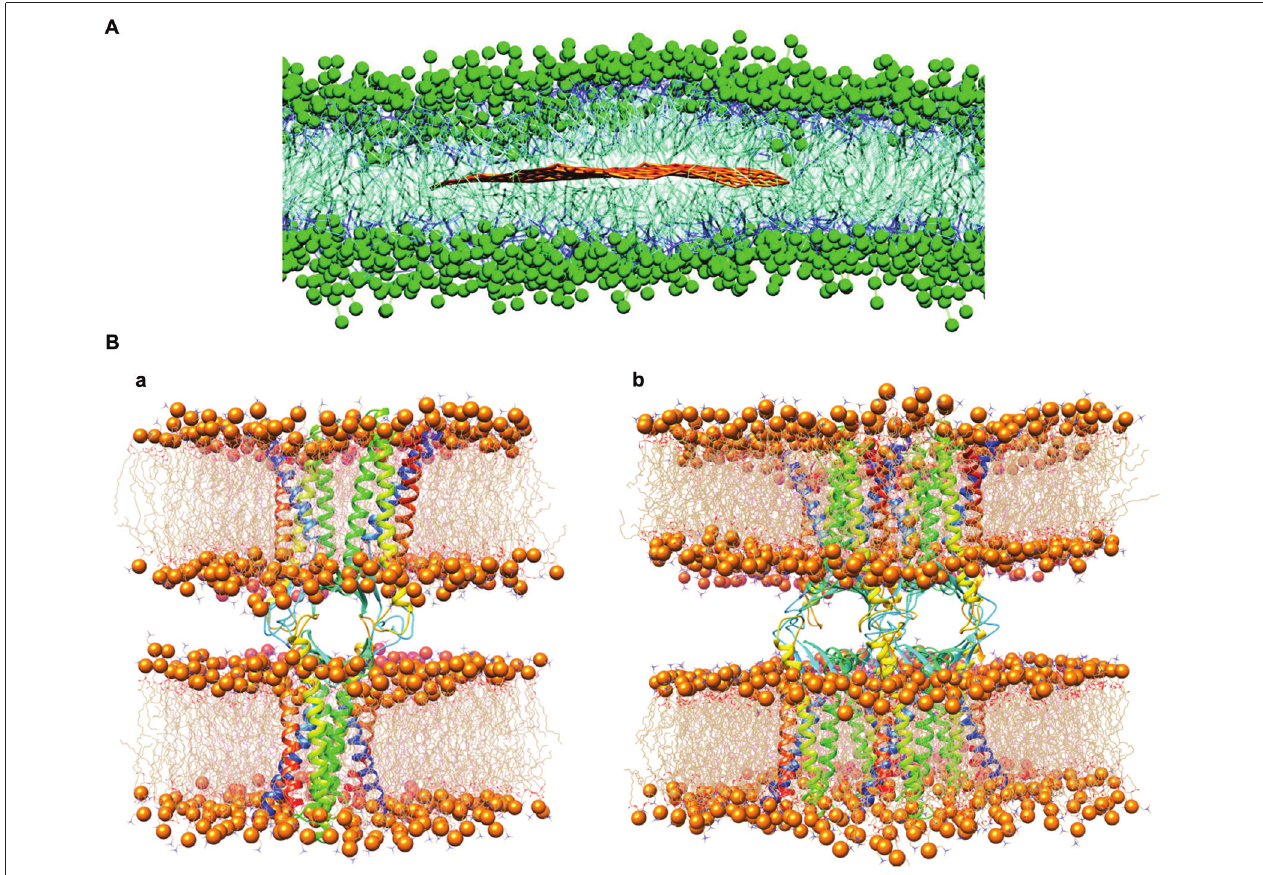
FIGURE 6 | Graphene interaction with biomembranes. (A) Equilibrated superstructure of a graphene sheet inside the phospholipid bilayer formed by 1-palmitoyl-2-oleoyl-sn-glycero-3-phosphocholine (POPC) lipids. Polar heads of the POPC lipids are depicted as green beads, hydrophobic hydrocarbon chains as thick blue lines; the graphene sheet is shown with brown lines (water molecules not shown; modified with permission from Titov et al., 2010). (B) The structure of single (a) and double (b) Cldn15-based paracellular pores, after the respective equilibration protocols. Protomers are shown as ribbons. Each cis dimer is embedded in a hexagonal POPC bilayer, shown as wire structures with phosphorus atoms as spheres. Modified with permission from Alberini et al.